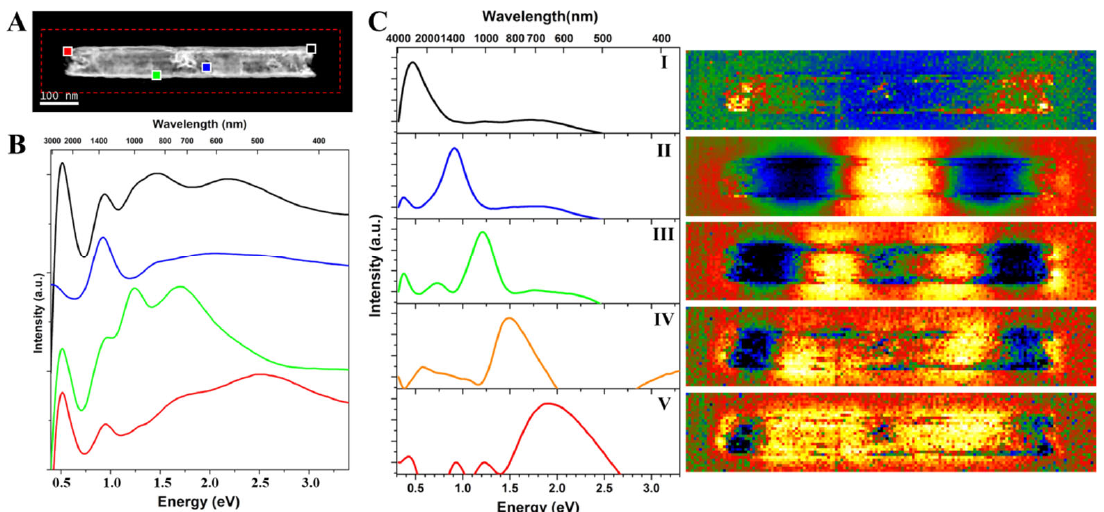
Figure 2. Plasmonic properties of a completely hollow AuAg nanotube. ( A ) HAADF ‐ STEM micro ‐ graph of the AuAg nanotube which is 84 nm in diameter and 665 nm in length. The area of the EELS SI is indicated with a red rectangle. ( B ) Background subtracted selected area EEL spectra of different locations marked in ( A ). ( C ) Spectra and corresponding abundance maps of five plasmonic compo ‐ nents obtained by VCA processing.